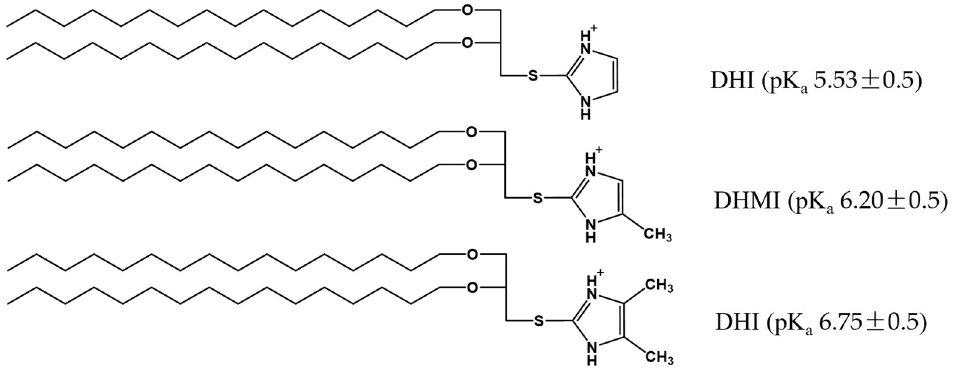
Figure 2. Imidazole-based, pH-sensitive lipids under study: chemical structures and calculated pKa by the ACD/pKa DB software.